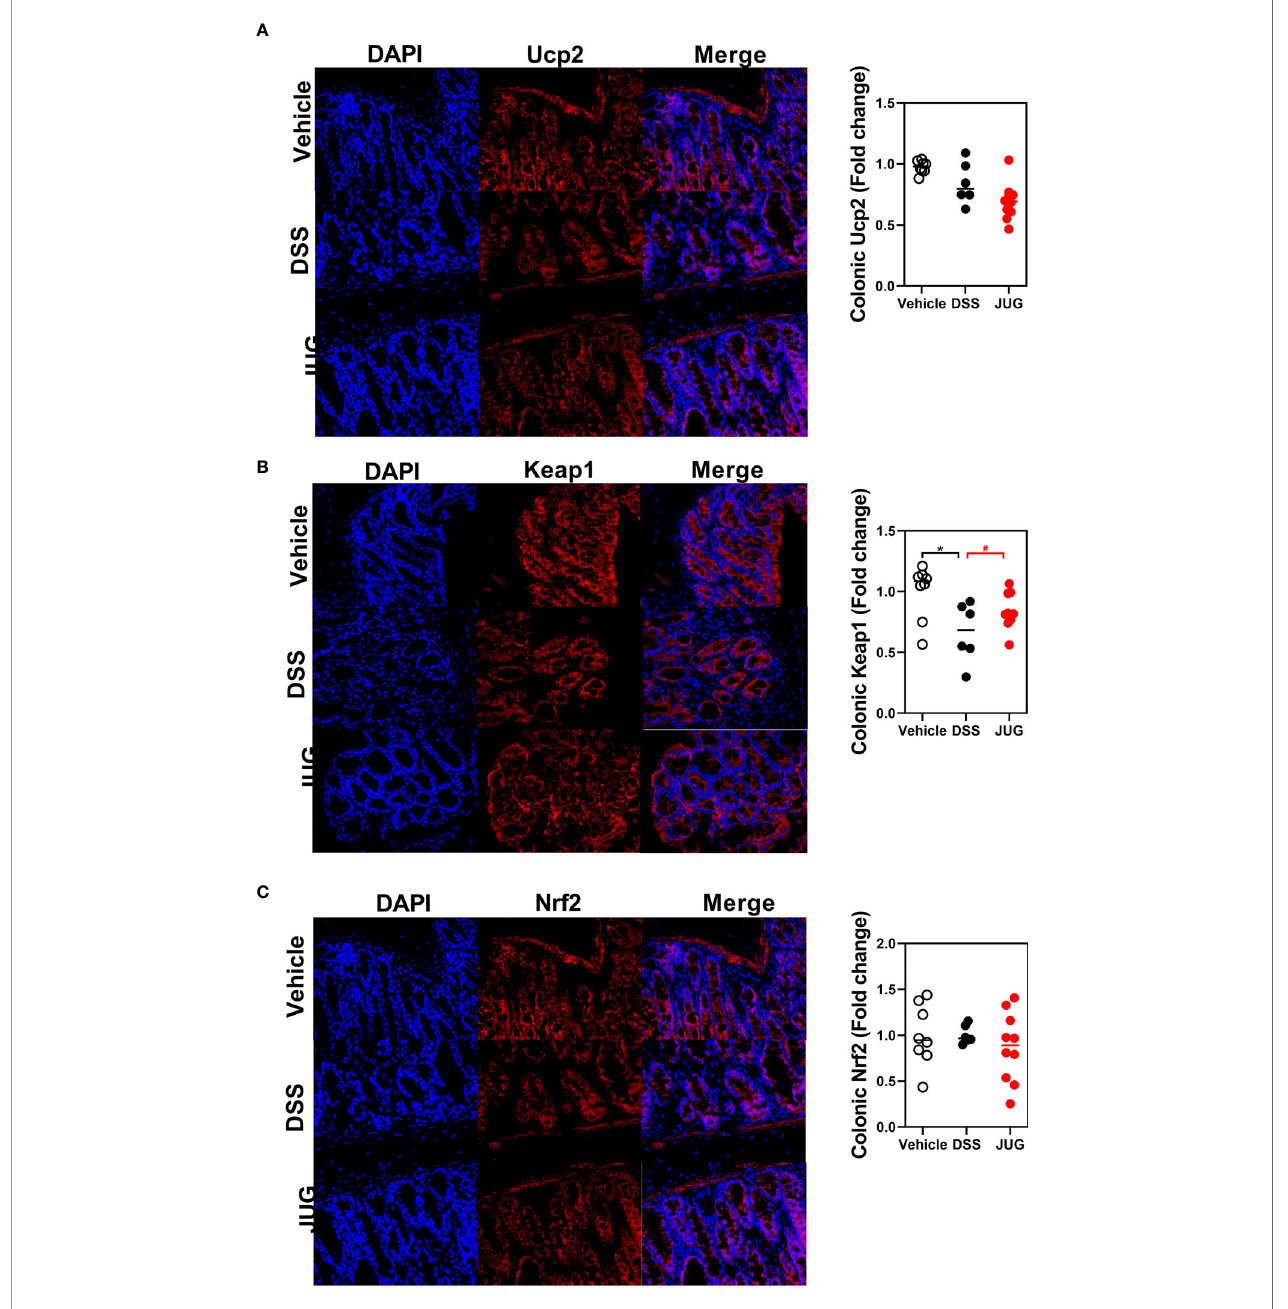
FIGURE 6 | Immuno fl uorescence staining for analysis of the DSS-induced oxidative damage. Immuno fl uorescence staining was assigned to measure the colonic expression of Ucp2 (A) , Keap1 (B) , and Nrf2 (C) . * meant P < 0.05, and # meant 0.1 < P < 0.05, vs. the DSS